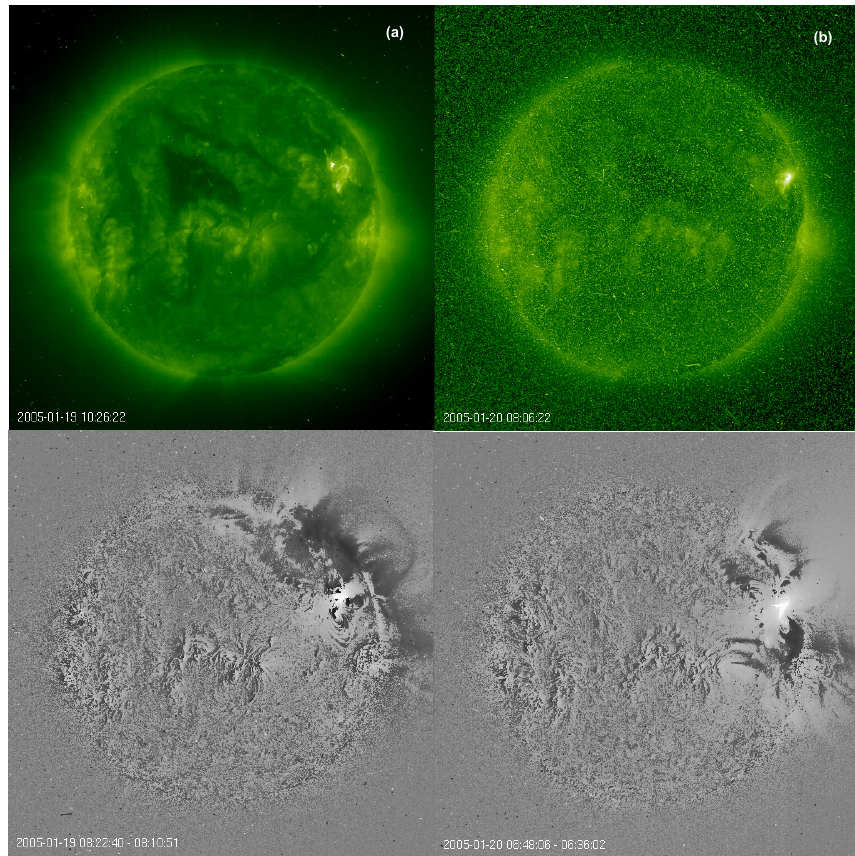
Fig. 10. EIT images of the post eruptive arcades (top panels) and coronal dimmings (bottom panels) corresponding to the activity in NOAA AR 10720 in January 2005. The lower panels show difference images. (a) CME from 19 January, (b) CME from 20